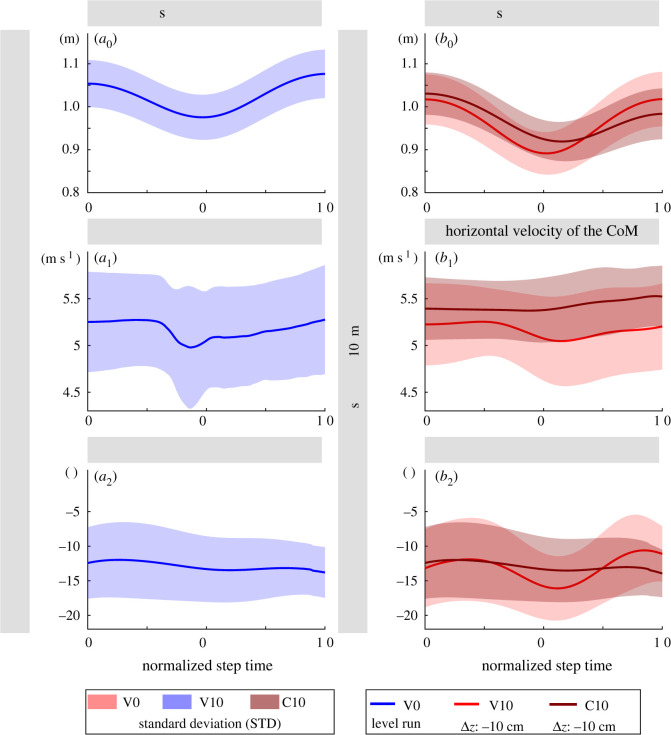
This figure is an extension of figure 9, with the difference that the standard deviation is plotted with the patches instead of the standard error.